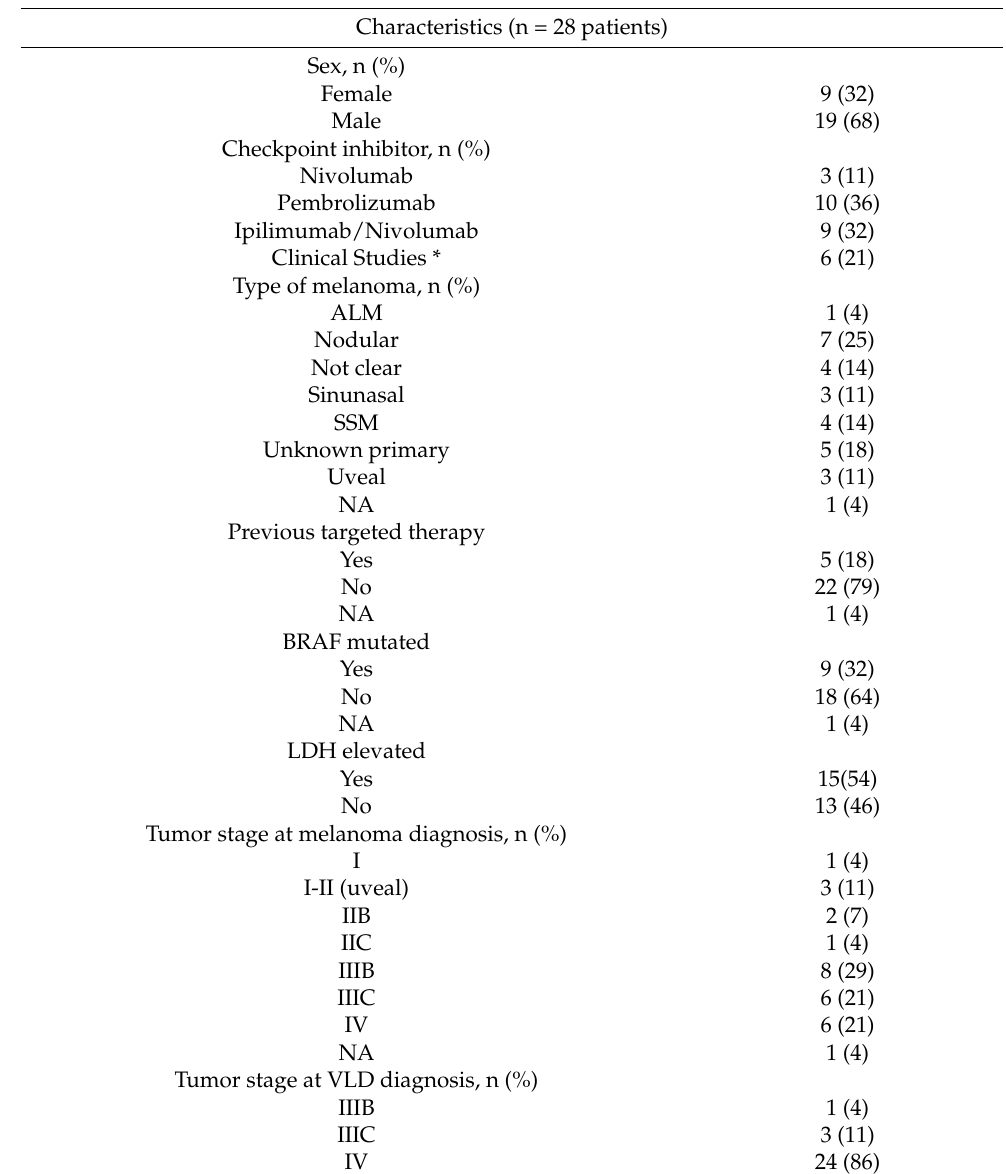
Table 1. Baseline